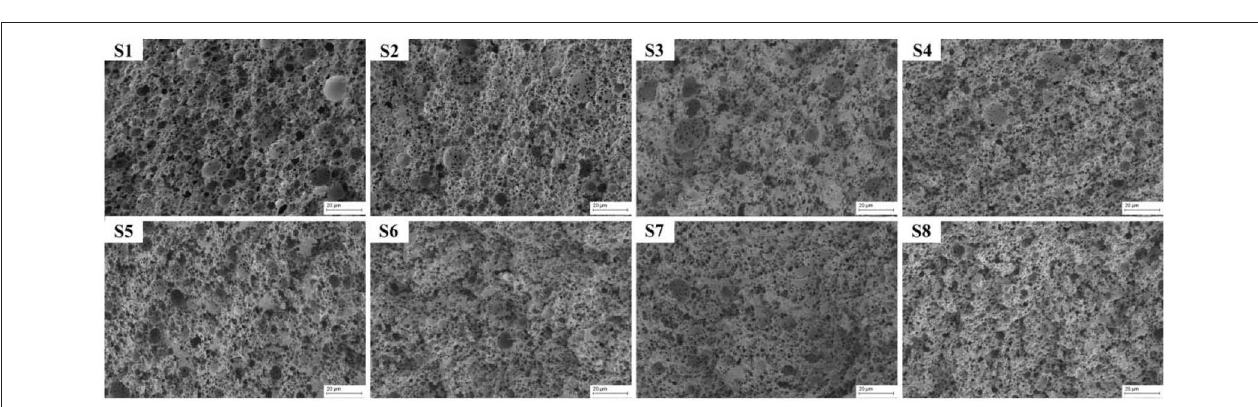
FIGURE 6 | SEM images of porous CMC- g -PAM/ATP prepared with different